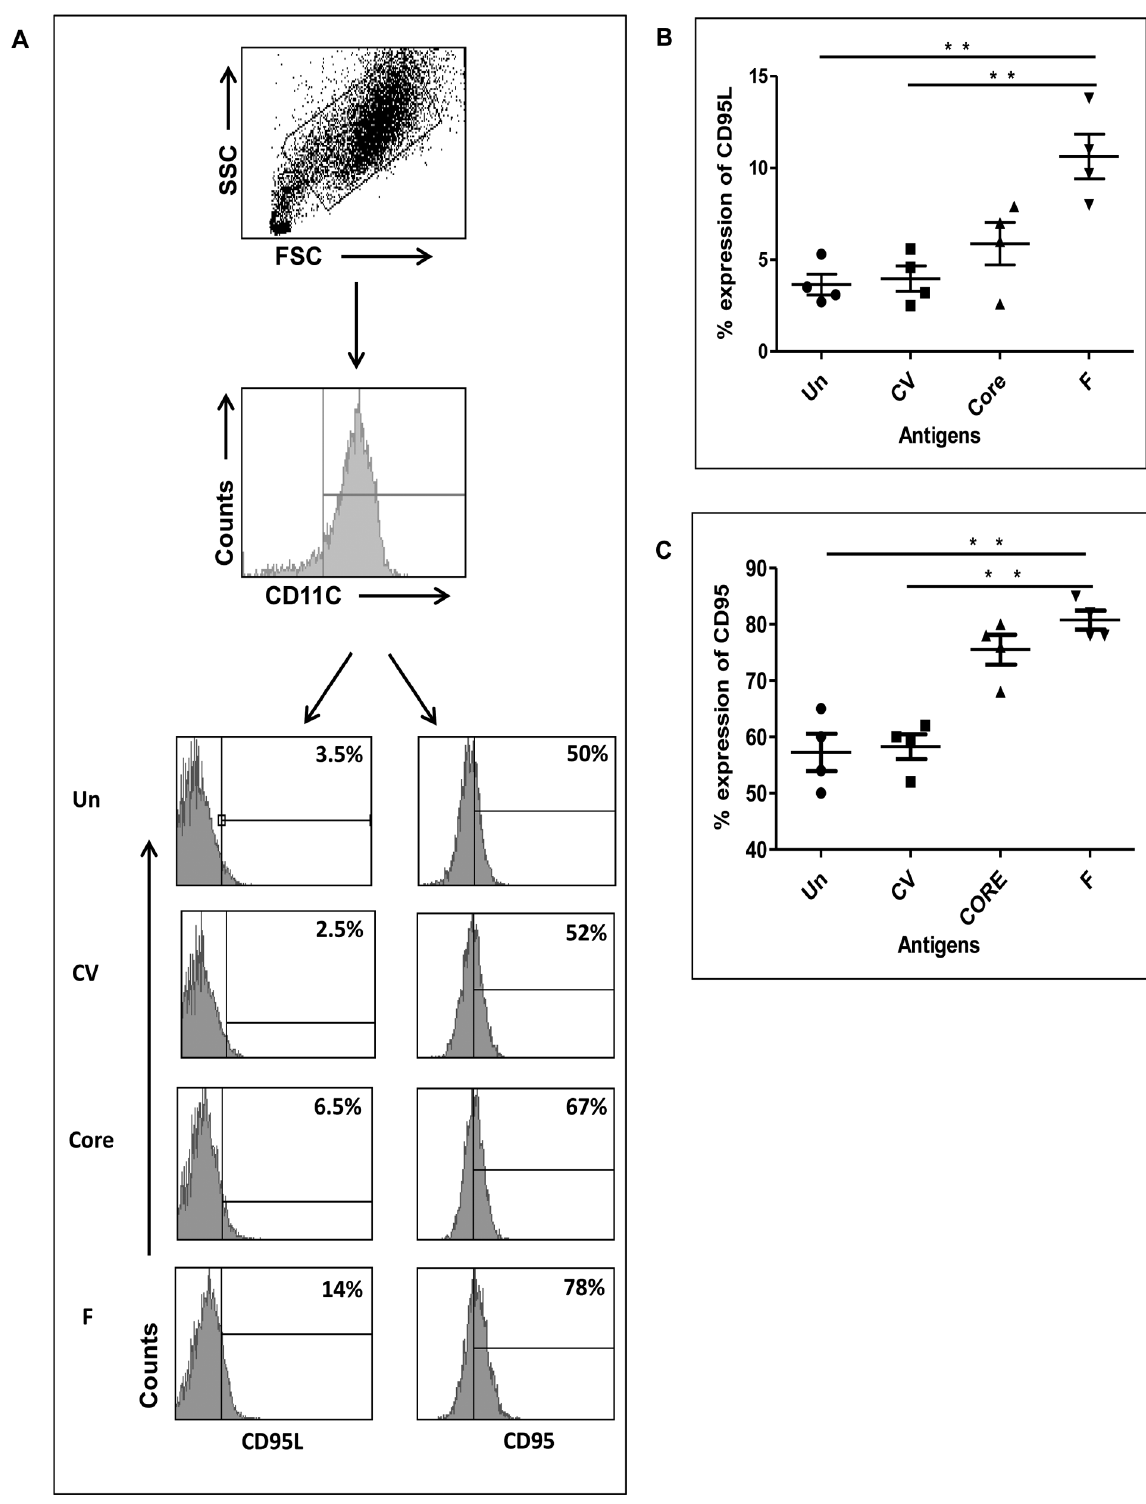
Figure 3. Expression of CD-95 and CD-95L in DCs expressing F or core protein. DCs were infected with adenovirus containing HCV-derived F and core antigens. After 48 hours of infection, DCs were harvested and stained with antibodies against CD-95L (A, left panel) and CD-95 (A, right panel). Data shown in panel A are representative of 5 different experiments done separately in 5 different donors. Cumulative statistical analysis of CD-95L (B) and CD-95 (C) expression is shown from four different donors.